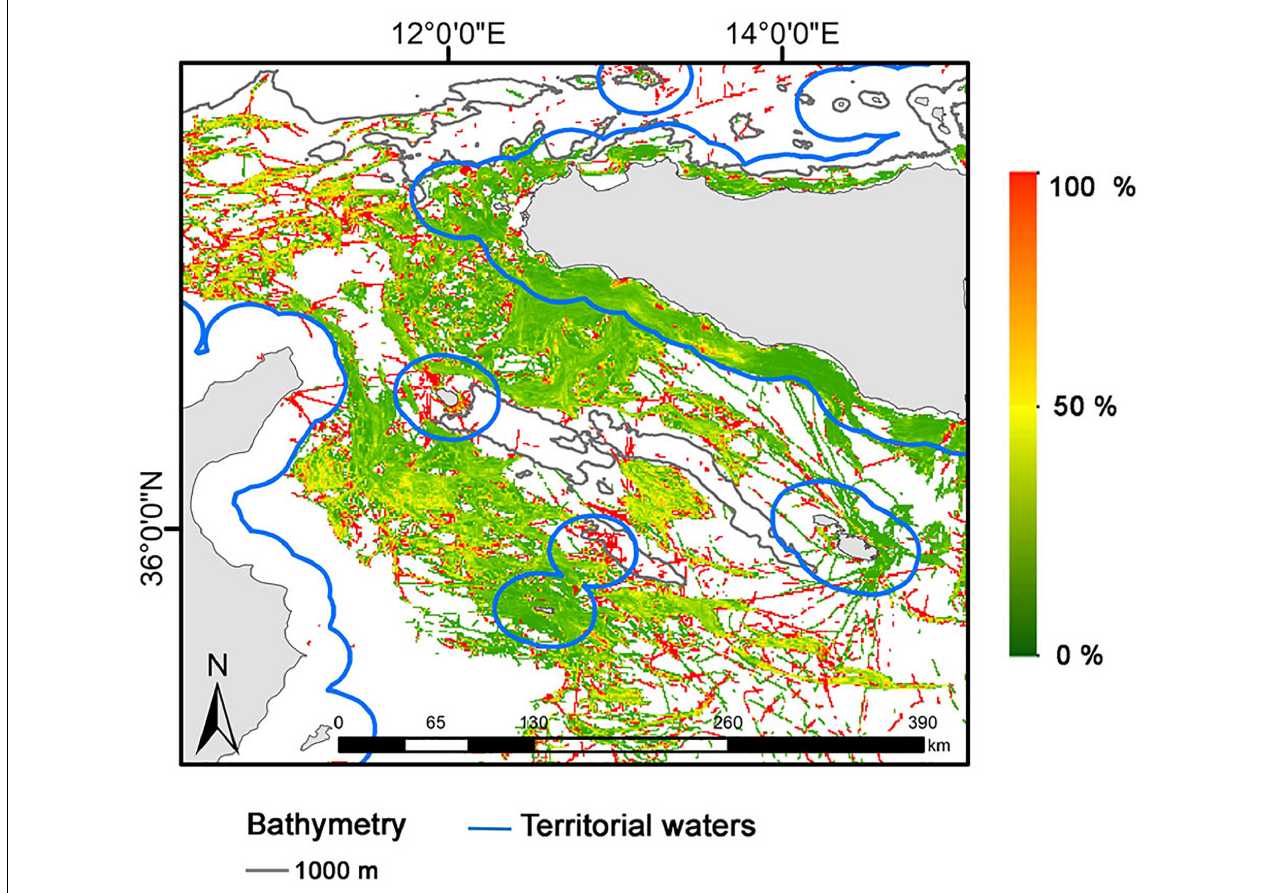
FIGURE 6 | Map of unobserved out of total fishing activity in the Strait of Sicily (percent values,